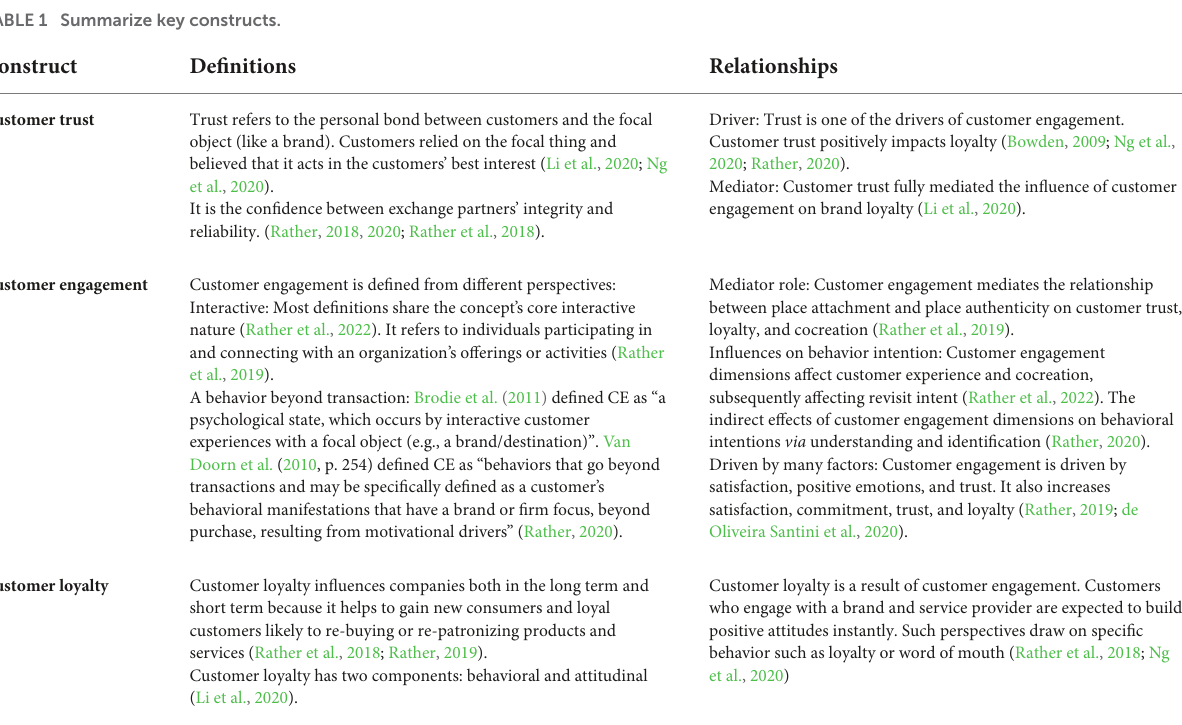
TABLE 1 Summarize key